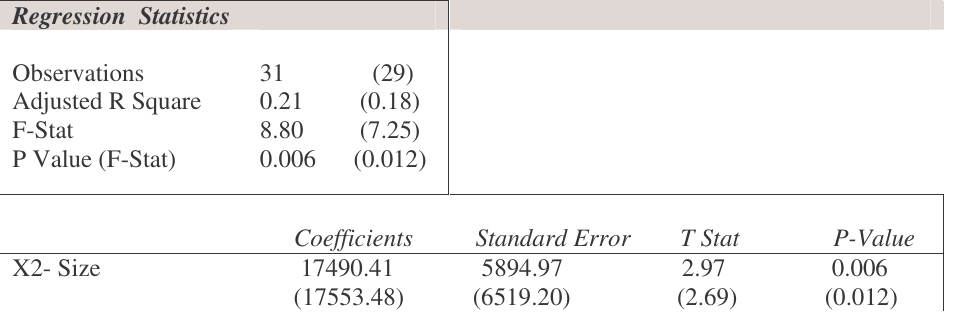
Table 2: Regression 2005 (2004 in parenthesis): sales versus size Regression